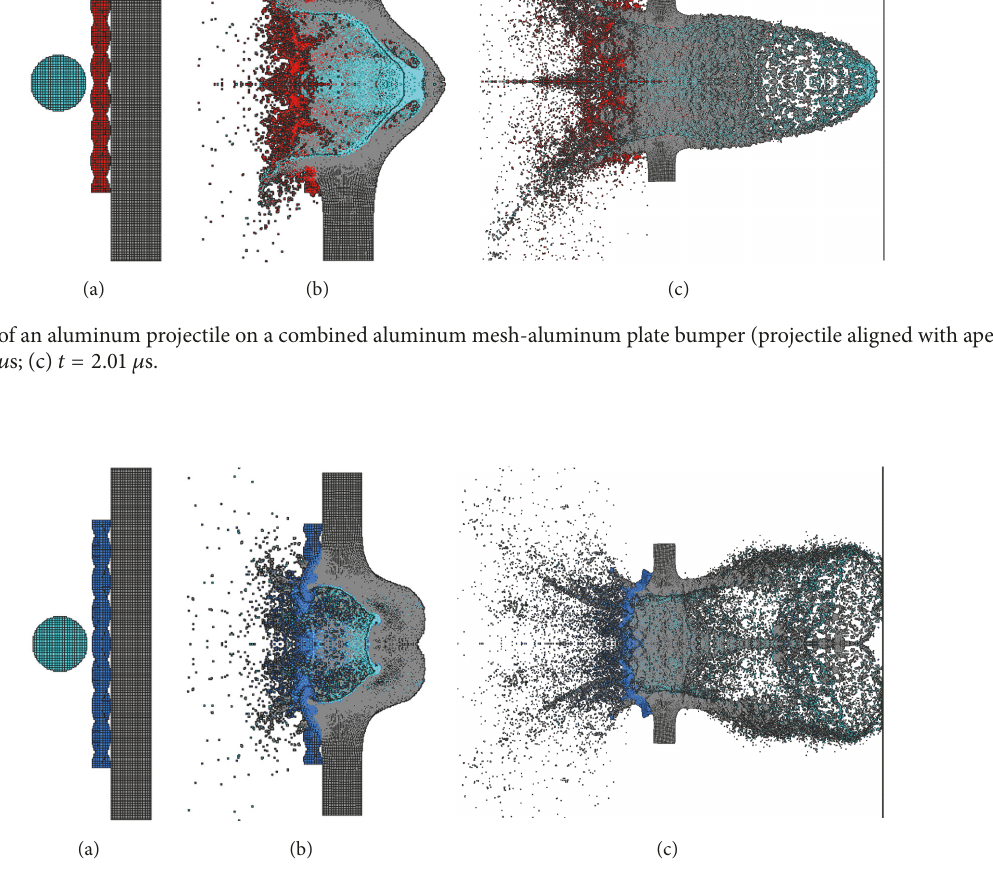
Figure 10: Impact of an aluminum projectile on a combined steel mesh-aluminum plate bumper (projectile aligned with crossover point): (a) 𝑡 = 0 ; (b) 𝑡 = 0.55 𝜇 s; (c) 𝑡 = 2.20 𝜇